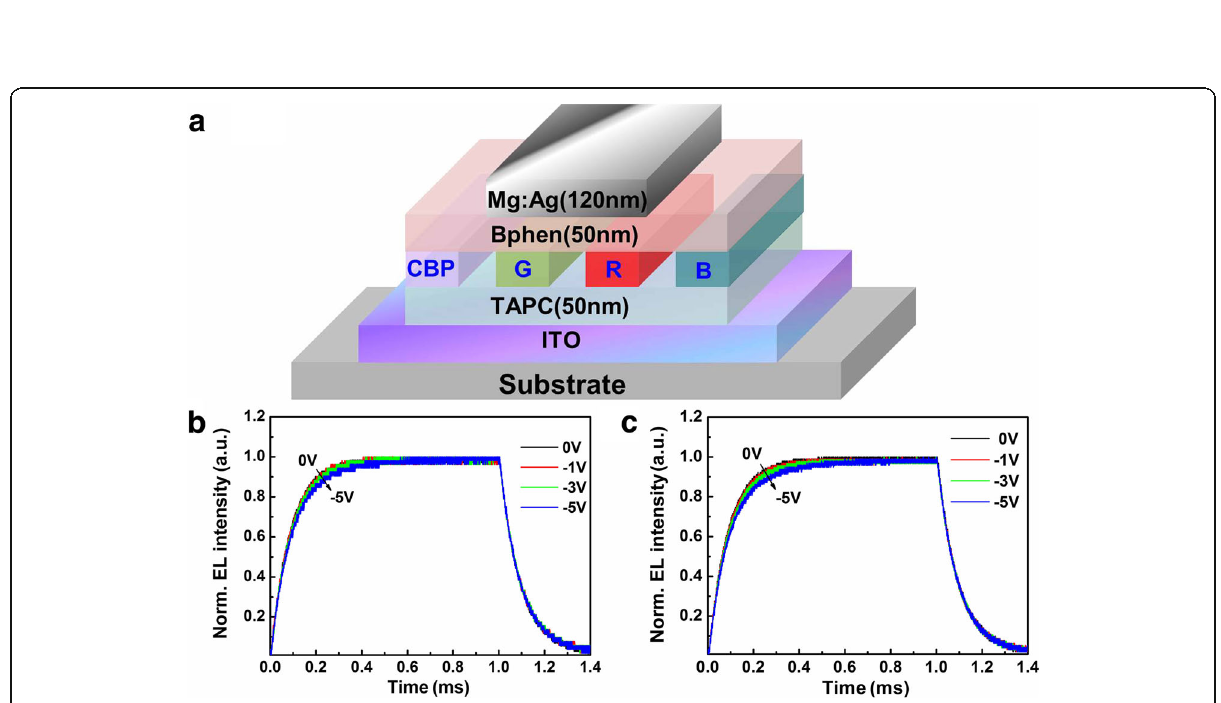
Fig. 5 a Structure of devices with the different dopant in EML: pure CBP layer without dopant, CBP-doped 10 wt% Ir(ppy) 3 (G) 5 wt% Ir(MDQ) 2 (acac) (R) and 15 wt% FIrpic (B). Normalized intensity of transient EL b Ir(MDQ) 2 (acac), c Ir(ppy) 3 depending on the reverse bias (0 V, − 1 V, − 3 V, and − 5 V) after the applied voltage turning off .The voltage pulse width was 1 ms, and the pulse frequency was 100 Hz. A current density of 90 mA cm − 2 was chosen to be the voltage pulse